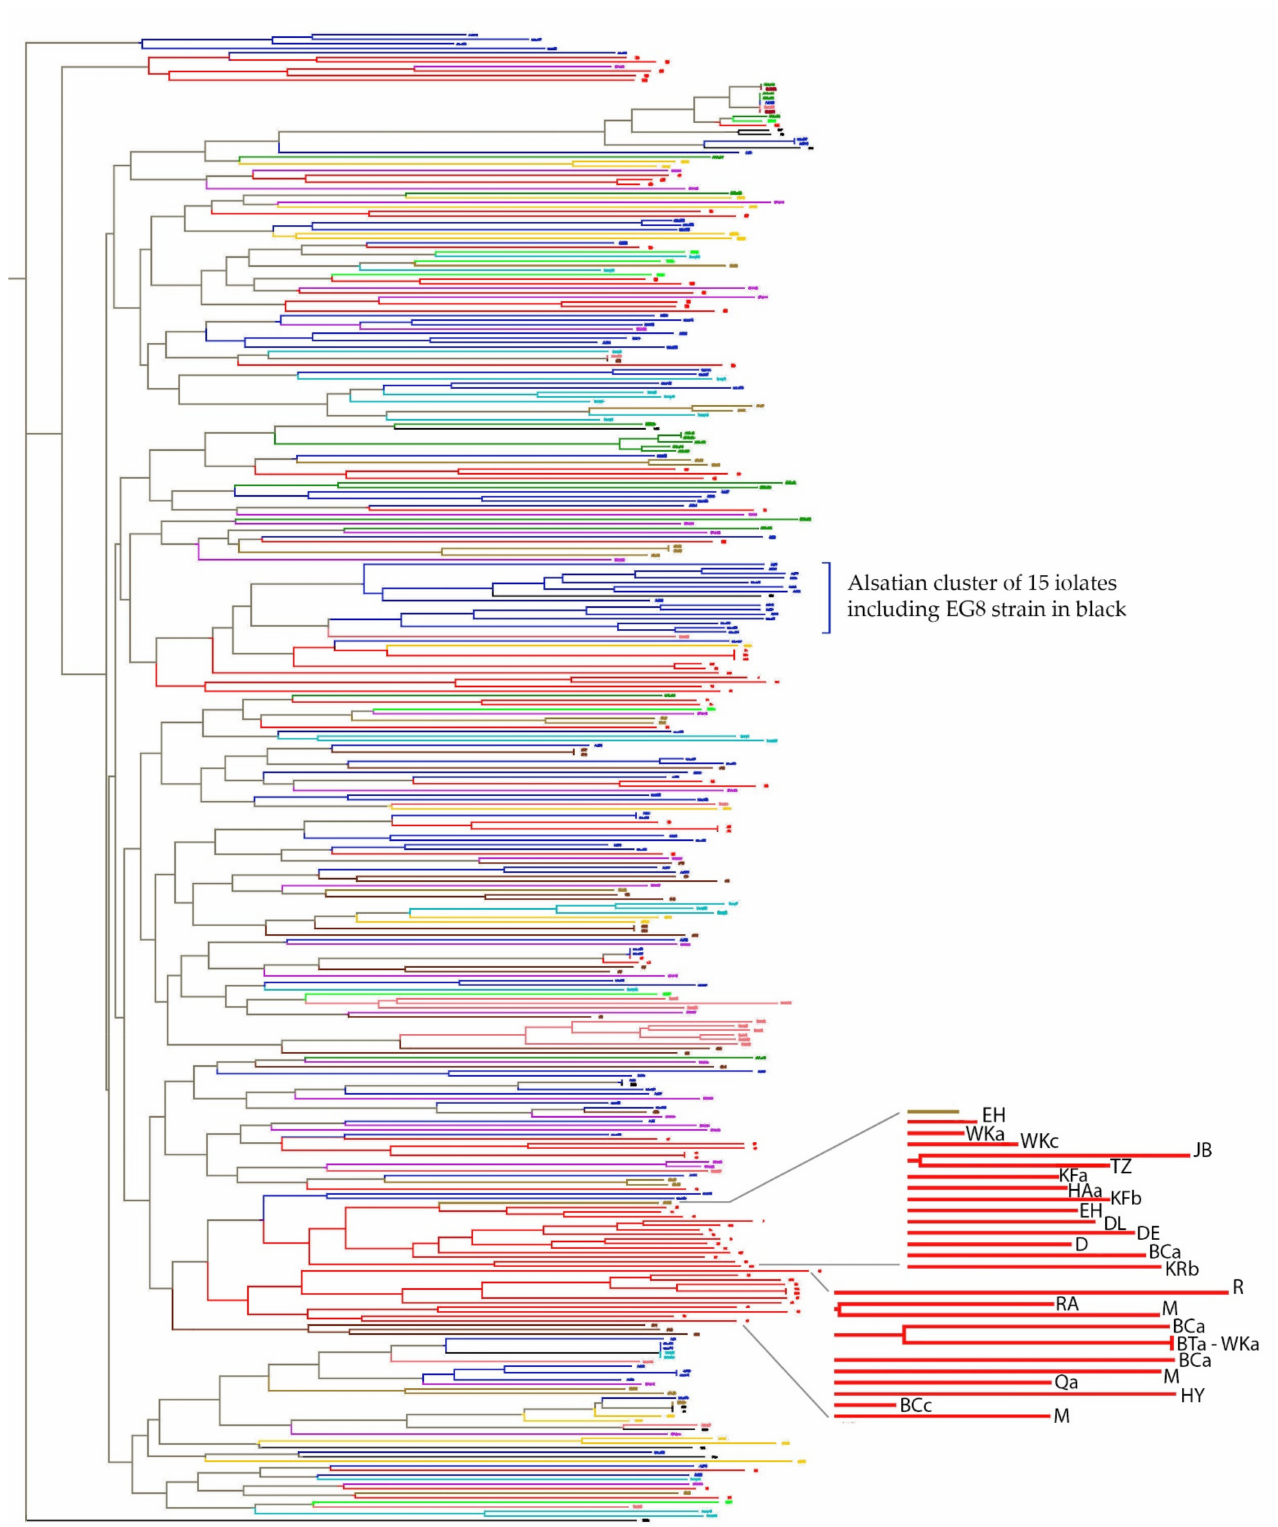
Figure 4. Clustering of Lebanese and worldwide oenological isolates according to microsatellites analysis. Lebanese isolates are in red. Isolates from Spain, South Africa, USA and Italy are respectively in violet, green, yellow and kaki. French isolates are coloured differently according to the region of isolation: those of Alsace, Montpellier, C ô tes du Rh ô nes, Nantes, Cognac and Champagne are respectively in dark blue, light blue, brown, pink, light green and orange. Isolates in black are the 11 commercial strains and S288C. Enlargement of Lebanese strains shows their